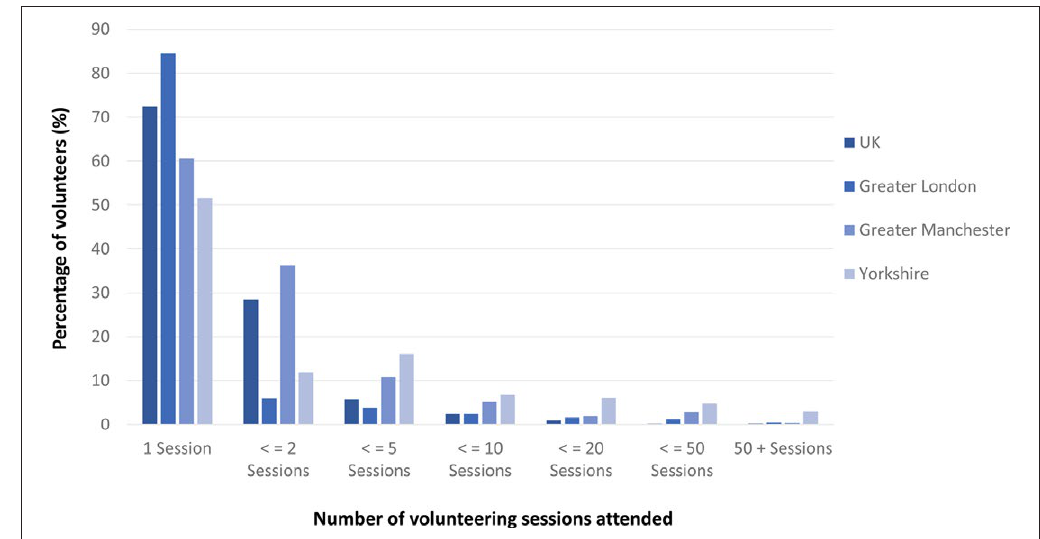
Figure 2: Total percentage of TCV volunteers attending volunteering